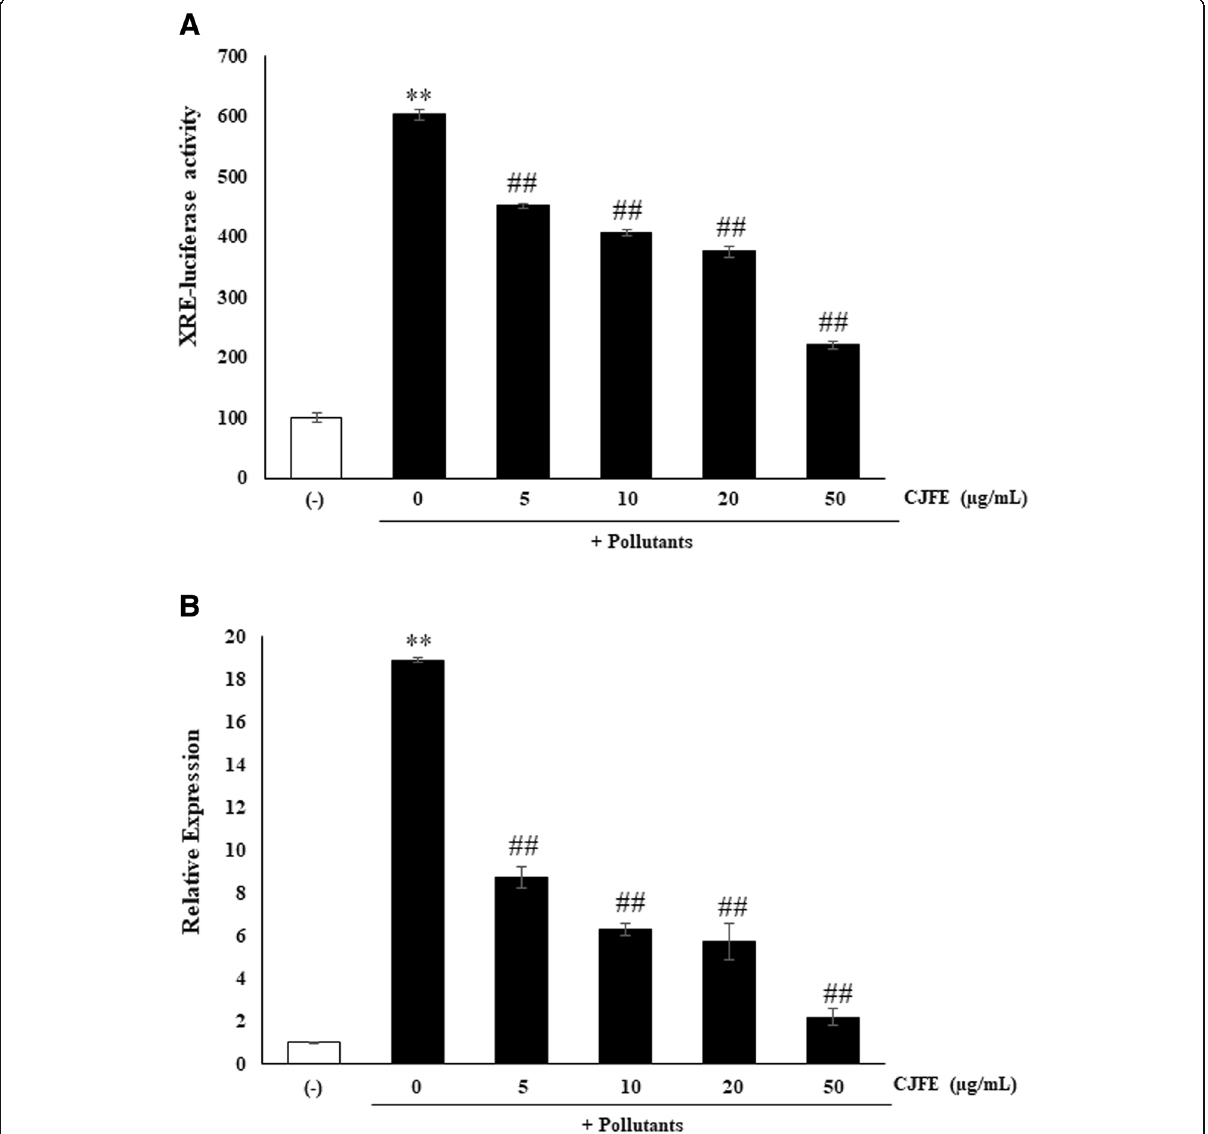
Fig. 3 Inhibitory effect of CJFE on the AhR signaling pathway induced by urban air pollutants. The inhibitory effect of CJFE on the AhR signaling pathway was determined by measuring the XRE-luciferase activity ( a ). The level of CYP1A1 expression in NHDFs was evaluated by quantitative RT- PCR assay ( b ). The results are mean ± standard deviation (SD) (n = 3). * P < 0.05, ** P < 0.01 vs. pollutant-untreated control. # P < 0.05, ## P < 0.01 vs. pollutant-treated